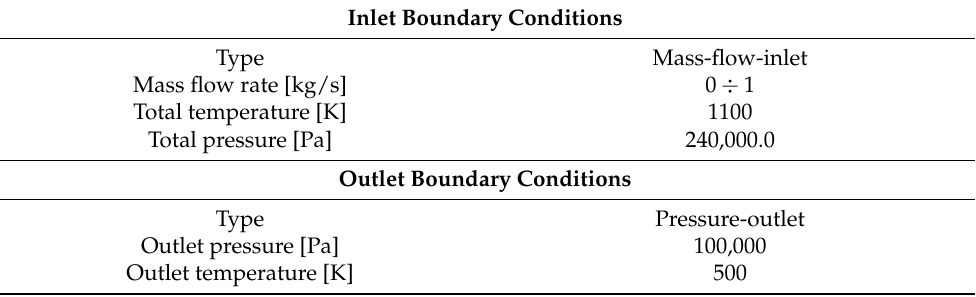
Table 4. The parameters of the boundary conditions.